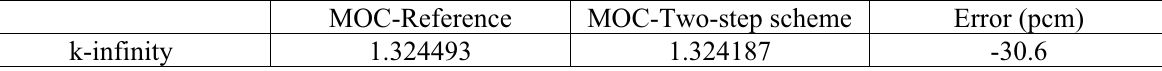
Figure. 3 The Distribution of RMS Relative Errors of Self-Shielded XSs Table II. The Comparison of K-Infinity in Multi-Assembly Problem